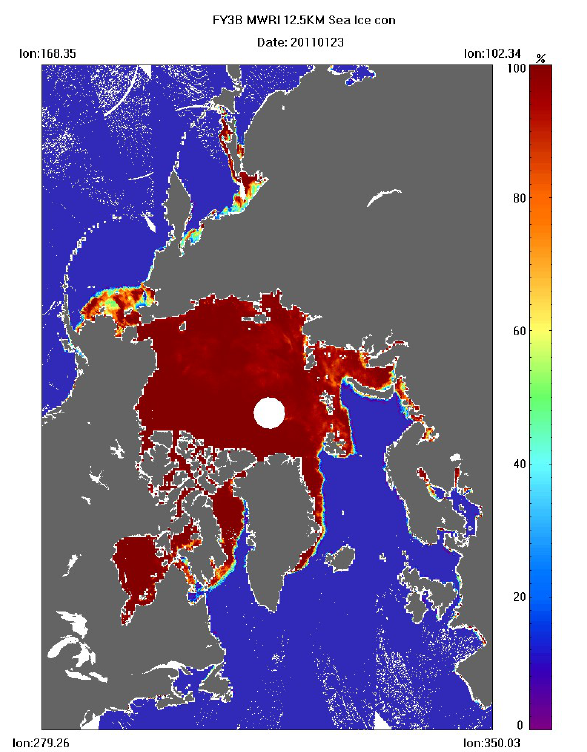
Figure 2. The sea ice concentration of MWRI on January 23, 2011